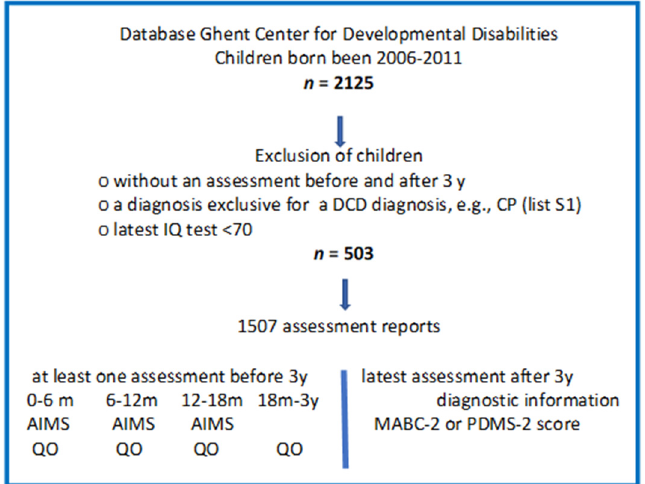
Figure 1. Research flow. m, months; y, years; QO, qualitative motor